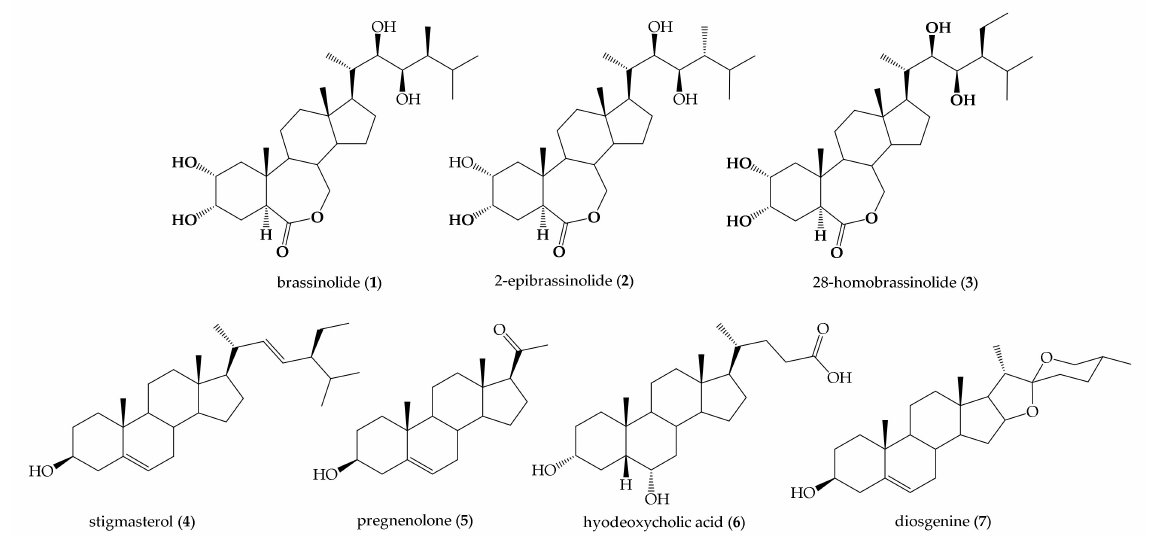
Figure 1. Structure of naturally occurring brassinosteroids and